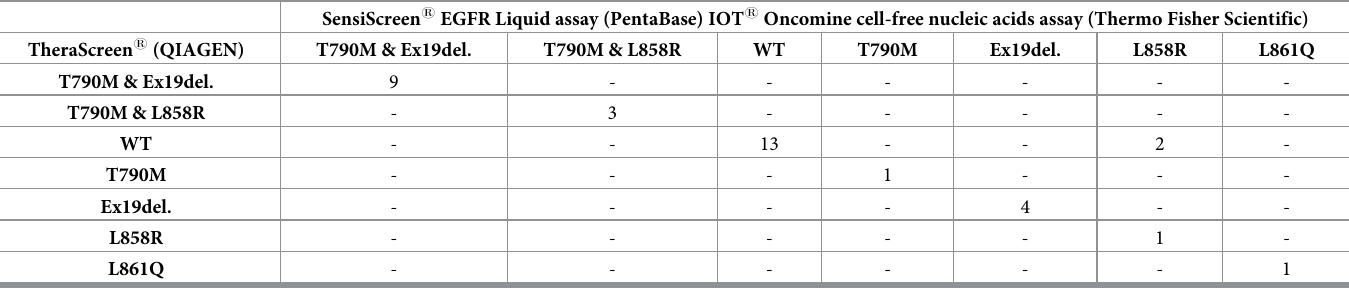
Table 2. Overview of the EGFR phenotypes detected by the Therascreen 1 (QIAGEN) versus SensiScreen 1 EGFR Liquid assay (Pentabase) and IOT 1 Oncomine cell-free nucleic acids assay (Thermo Fisher Scientific) using cohort I and agreement or disagreement between platforms (N =